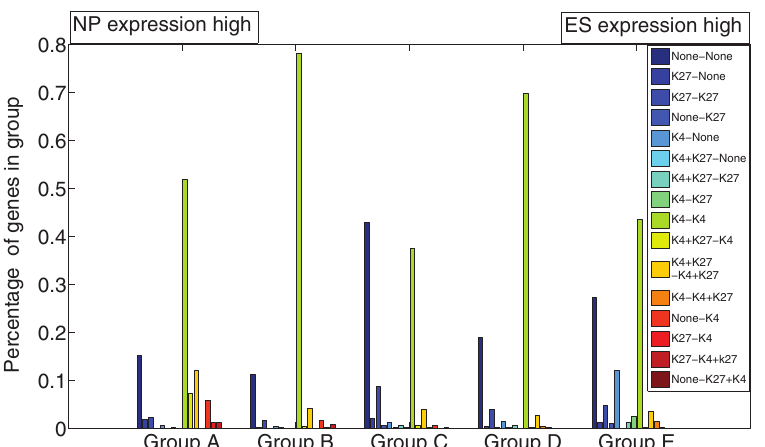
Figure 12. Bivalent gene profile vs. expression data. Genes are grouped in (A–E) according to increasing ratio of expression level in ES cells and NP cells. Each bar shows the percentage of genes with the corresponding ‘‘A–B’’ modifications (as listed in the box), ‘‘A’’ for modifications in ES cells and ‘‘B’’ for modifications in NP cells. It is seen that there is a strong over-representation of the K4 + K27-K4 transition (yellow) in the genes class, which is strongly up-regulated in NP